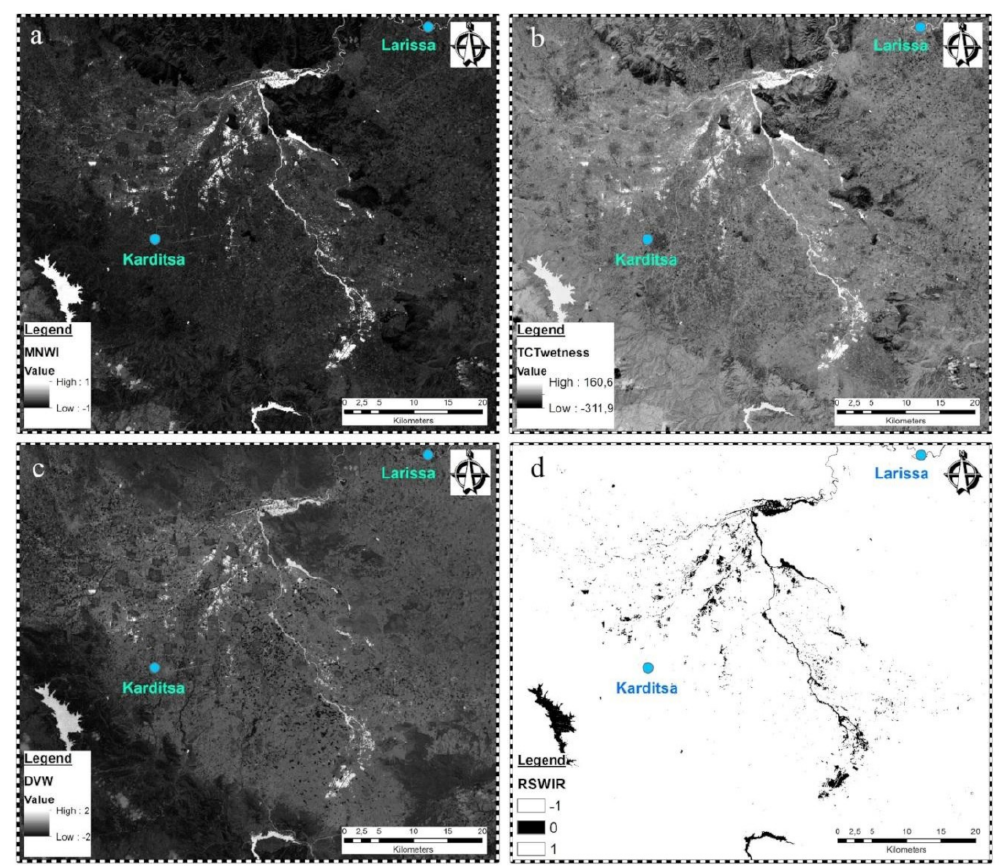
Figure 8. The four implemented water indices. ( a ) MNDWI; ( b ) TCW; ( c ) DVW; and ( d )